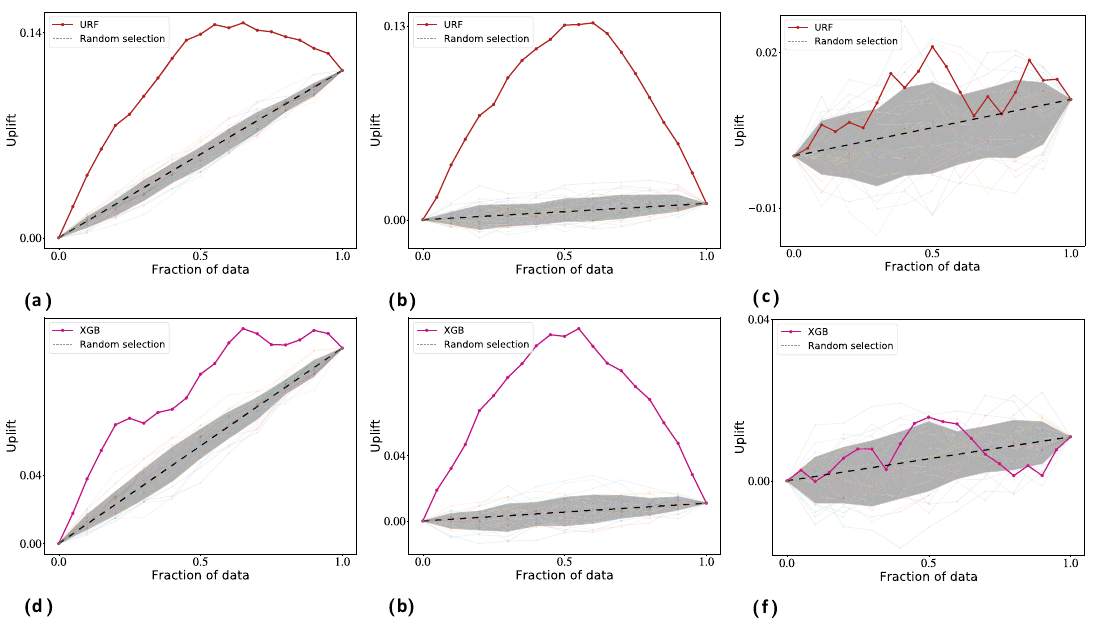
Figure 3: Static CATE models in a drifting environment. qini - charts above illustrate performance by the URF, qini - charts below illustrate performance by XGB. On the x - axis, we have the fraction of the data, where each model ranks the data from left - to - right, with highest CATE to lowest ITE. On the y - axis, we calculate the actual CATE ( termed uplift ) in the data ranked higher than x . Grey areas indicate prediction noise. An ideal model will have a line far above the random line. While models in a static environment seem to accurately predict the CATE ( left and middle ) , when faced with a dynamic environment, performance drops signi fi cantly ( rightmost )